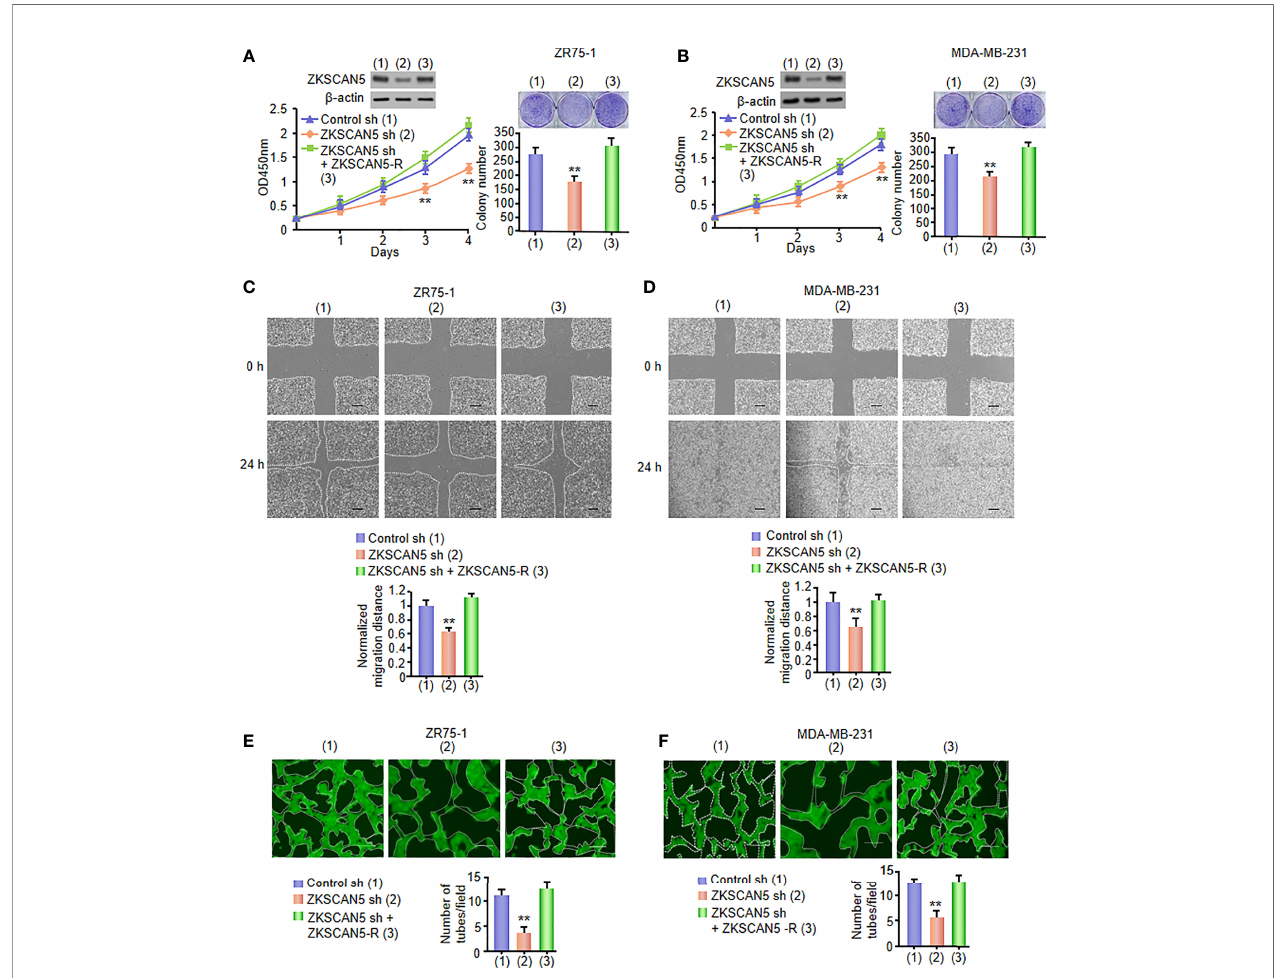
FIGURE 2 | VEGFC secreted by cancer cells, under the in fl uence of ZKSCAN5, regulates HLEC proliferation, migration, and tube formation. (A, B) Cell proliferation and colony formation assays in HLECs cultured in conditioned medium come from ZR75-1 or MDA-MB-231 cells stably infected with lentivirus carrying ZKSCAN5 shRNA or ZKSCAN5 shRNA plus ZKSCAN5-R. The representative Western blot displays the expression of ZKSCAN5. **p < 0.01 versus the control shRNA group (A, B) . (C, D) Wound healing assays for HLECs cultured in conditioned medium from ZR75-1 or MDA-MB-231 cells, which were stably infected as in (A). The image shown is one of the representative results (C, D) . Scale bar: 100 m m. (E, F) Tube formation assays for HLECs cultured in the conditioned medium from ZR75-1 or MDA-MB-231 cells, which were stably infected as in (A) . All values shown are the mean ± SD of triplicate measurements and were repeated three times with analogous results (C, D) . *p < 0.05 versus control shRNA. **p < 0.01 versus control